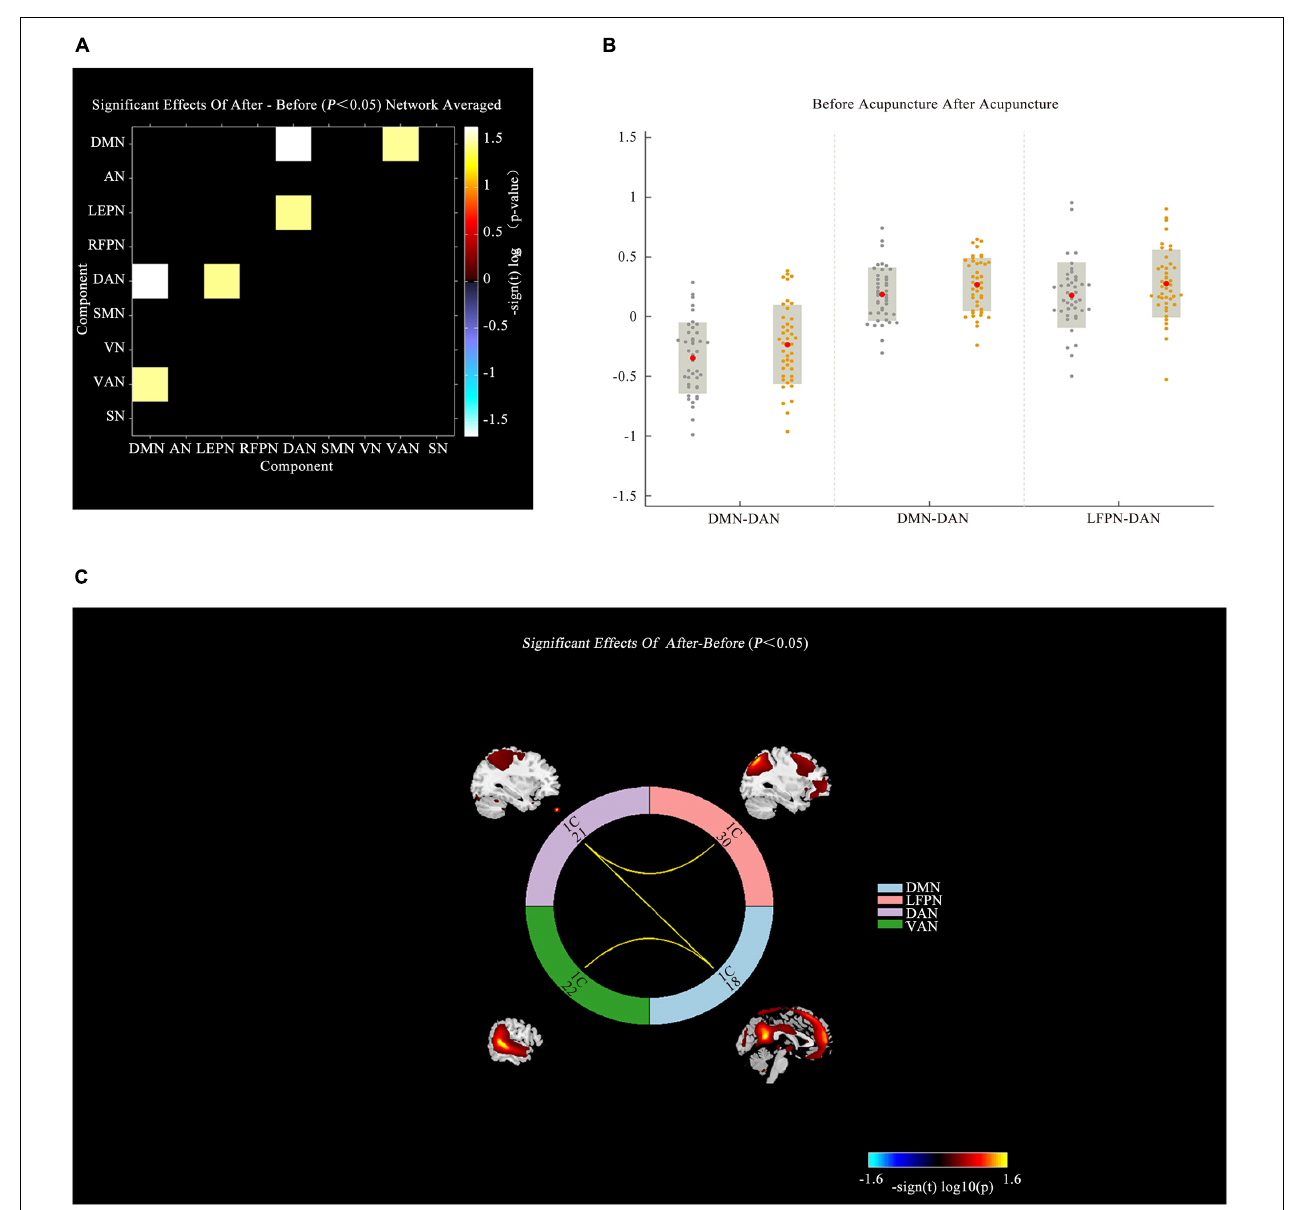
FIGURE 5 | Connectivity comparisons of large-scale network between the IBS-D patients before and after acupuncture. (A) Connectivity matrix of functional network connectivity of large-scale network in IBS-D before and after acupuncture. (B) The changes of functional network connectivity of large-scale network in IBS-D before and after acupuncture. (C) Connectivity of functional network connectivity of large-scale network in IBS-D patients before and after acupuncture; Hot colors represent positive functional connectivity, and cool colors represent negative functional connectivity. LFPN, left frontoparietal Network; DMN, anterior default mode network; SN, salience network; VAN, ventral attention network; AN, auditory network; VN, visual network; SMN, sensorimotor network; DAN, dorsal attention network; RFPN, right frontoparietal network; L, left; R, right.